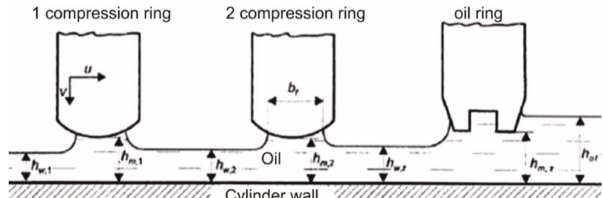
Fig. 2. The scheme of relation between the piston rings and cylinder wall [6]